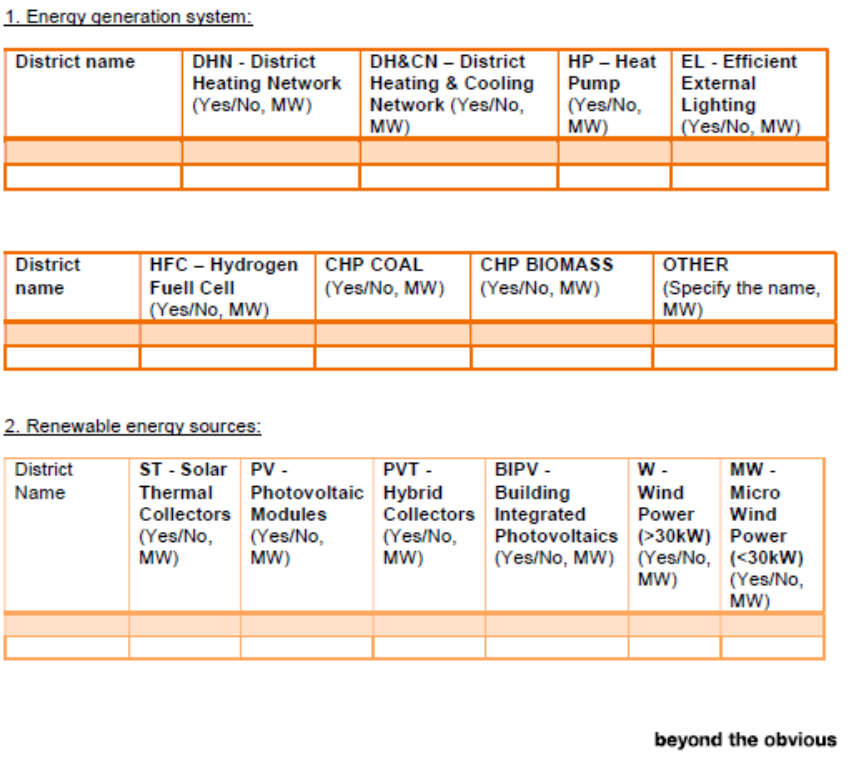
Figure A2. Copy of the second page of the questionnaire produced to conduct this study.